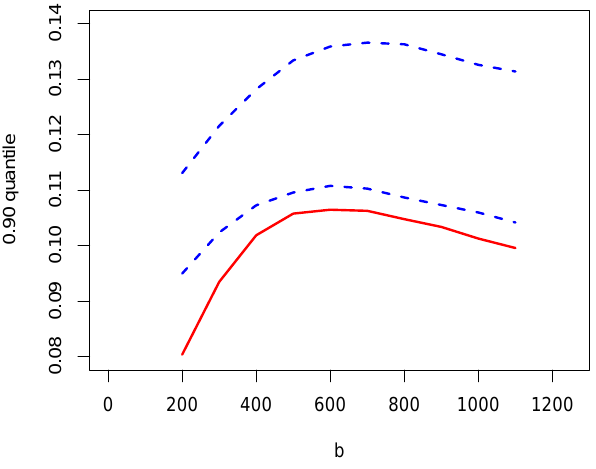
Fig. 6. Quantiles Q 0 . 90 in Eq. (8) estimated for different b using pseudo realizations generated from one record: each blue dashed curve is based on pseudo realizations generated from a record of model time series (9), while the solid red curve is based on pseudo realizations generated from the record in Fig.